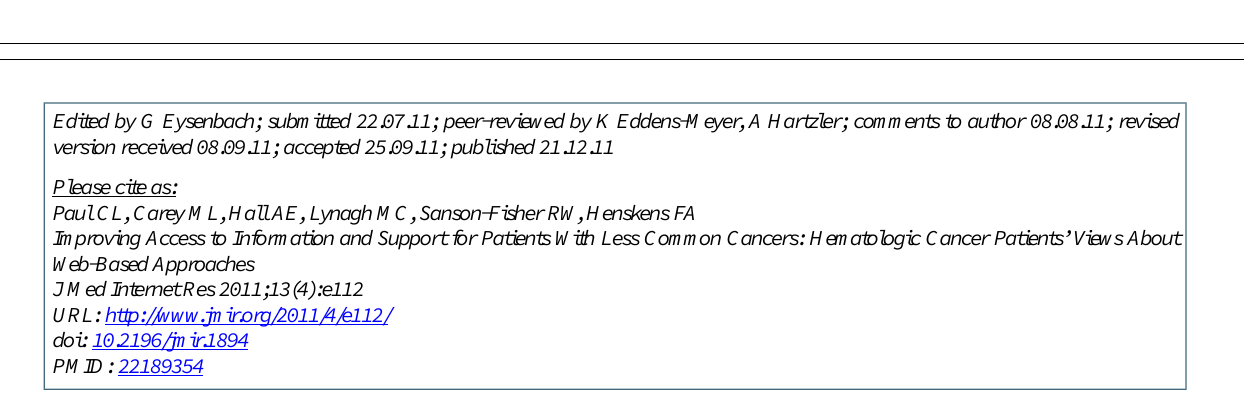
Abbreviations CI: confidence